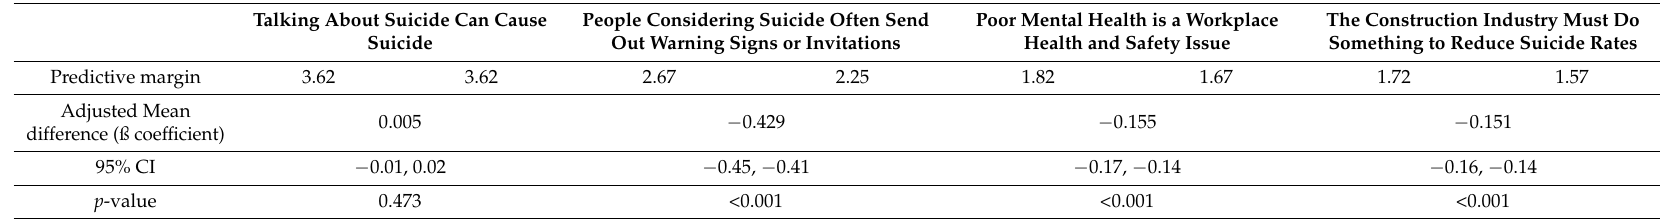
Table 3. Predictive margins for pre- and post -test beliefs, and mean differences in change in beliefs * #.